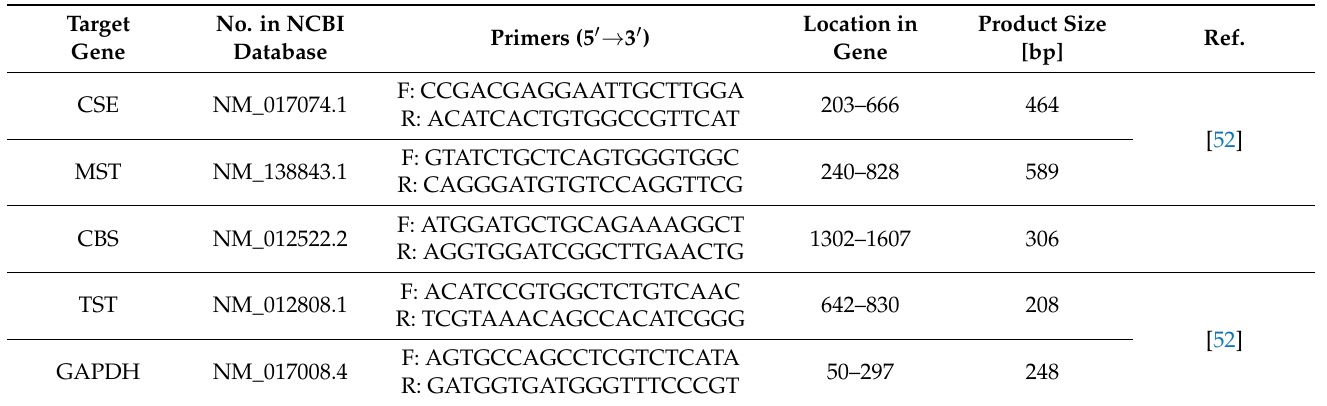
Table 2. Primer sequences used for determination of target genes by